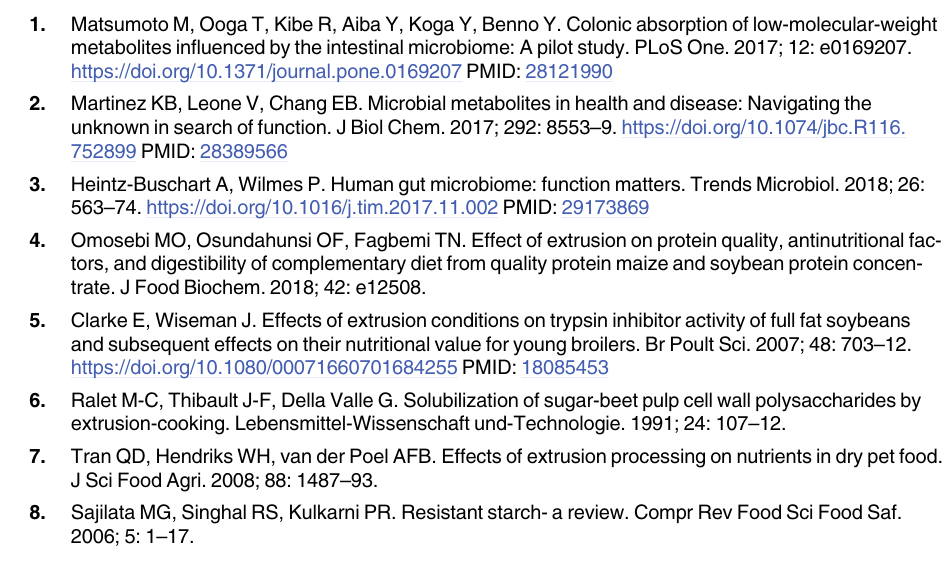
S2 Table. Mean food intakes and undigested nutrients. S3 Table. Mean values at weeks 3 and 6 in fecal proximate analysis, minerals, short-chain